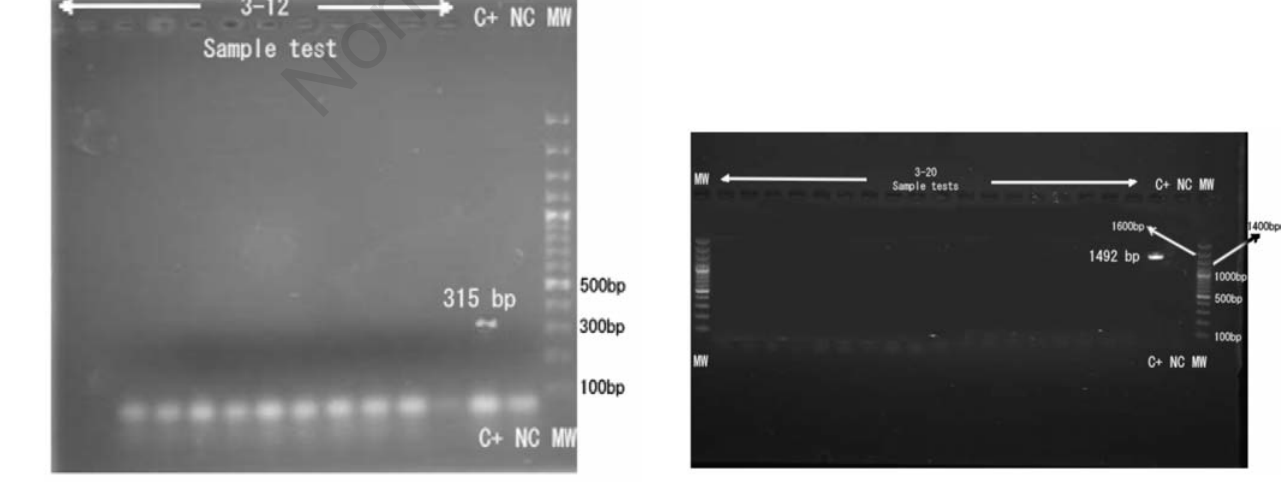
Figure 1. Image of the ethidium bromide stained gel of 315 bp band in urine polymerase chain reaction products. MW, 100 bp molecular weight ladder. Lane 1, negative control, Lane 2, posi- tive control, Lanes, 3-12 urine samples.